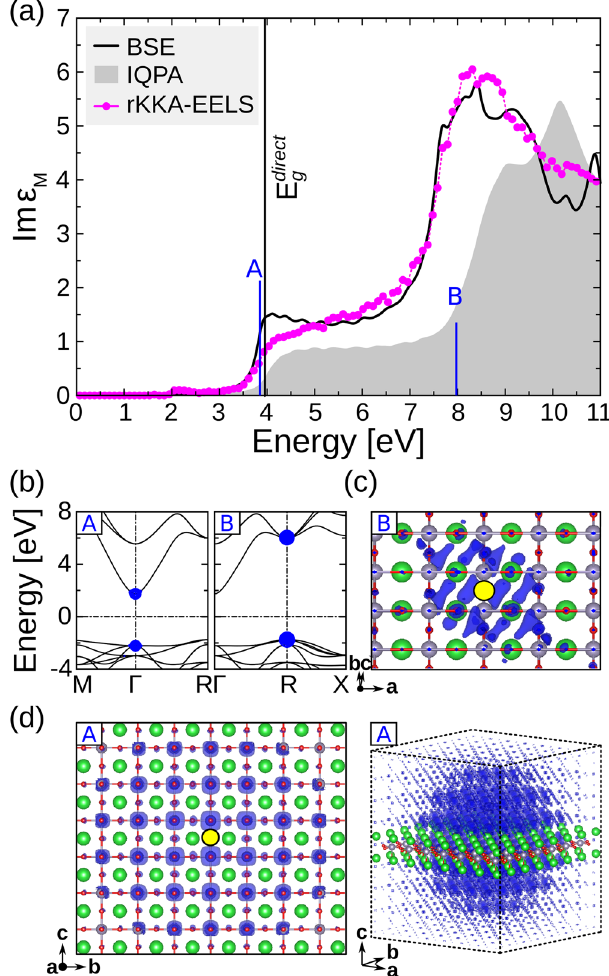
Fig. 4 Optical absorption of cubic BaSnO 3 . a Imaginary part of the macroscopic dielectric function obtained from the Bethe – Salpeter equation (BSE), which includes excitonic effects (solid line). The independent quasiparticle spectrum (IQPA), is shown for comparison. A Lorentzian broadening of 0.15 eV is applied to both spectra to mimic excitation lifetimes. The experimental result (magenta circles) is obtained by applying relativistic Kramers – Kronig analysis (rKKA) to electron energy-loss spectroscopy (EELS) data. b Band contributions to excitations (A) and (B) marked in the BSE spectrum. c , d Spatial distribution of the electron – hole wavefunction for excitations (A) and (B), with the hole fi xed on the O atom (yellow spots). In d , we also show the three-dimensional electron distribution of excitation A, where only a few atomic layers of the BaSnO 3 structure are shown to ease the visualization.